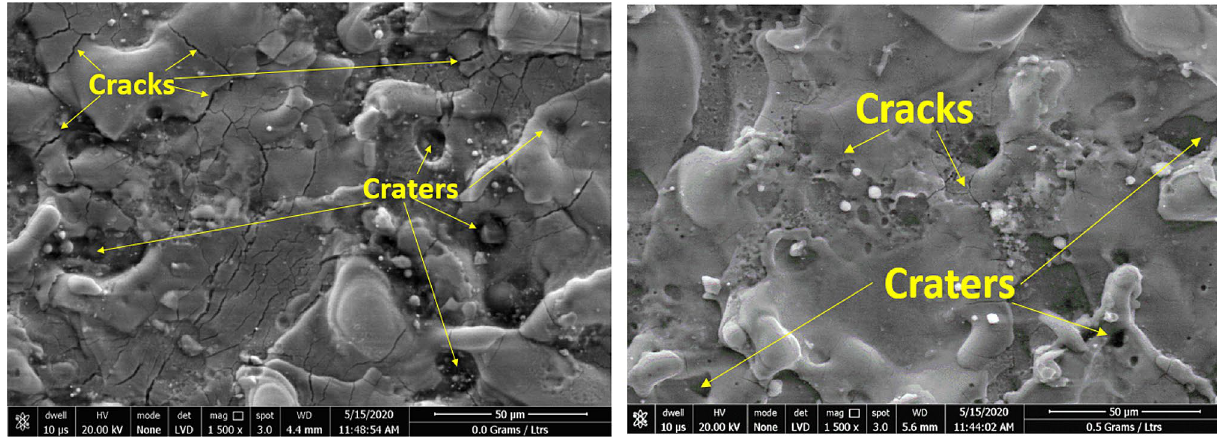
Fig. 5 a SEM micrograph of the ED machined surface at I machined surface at I